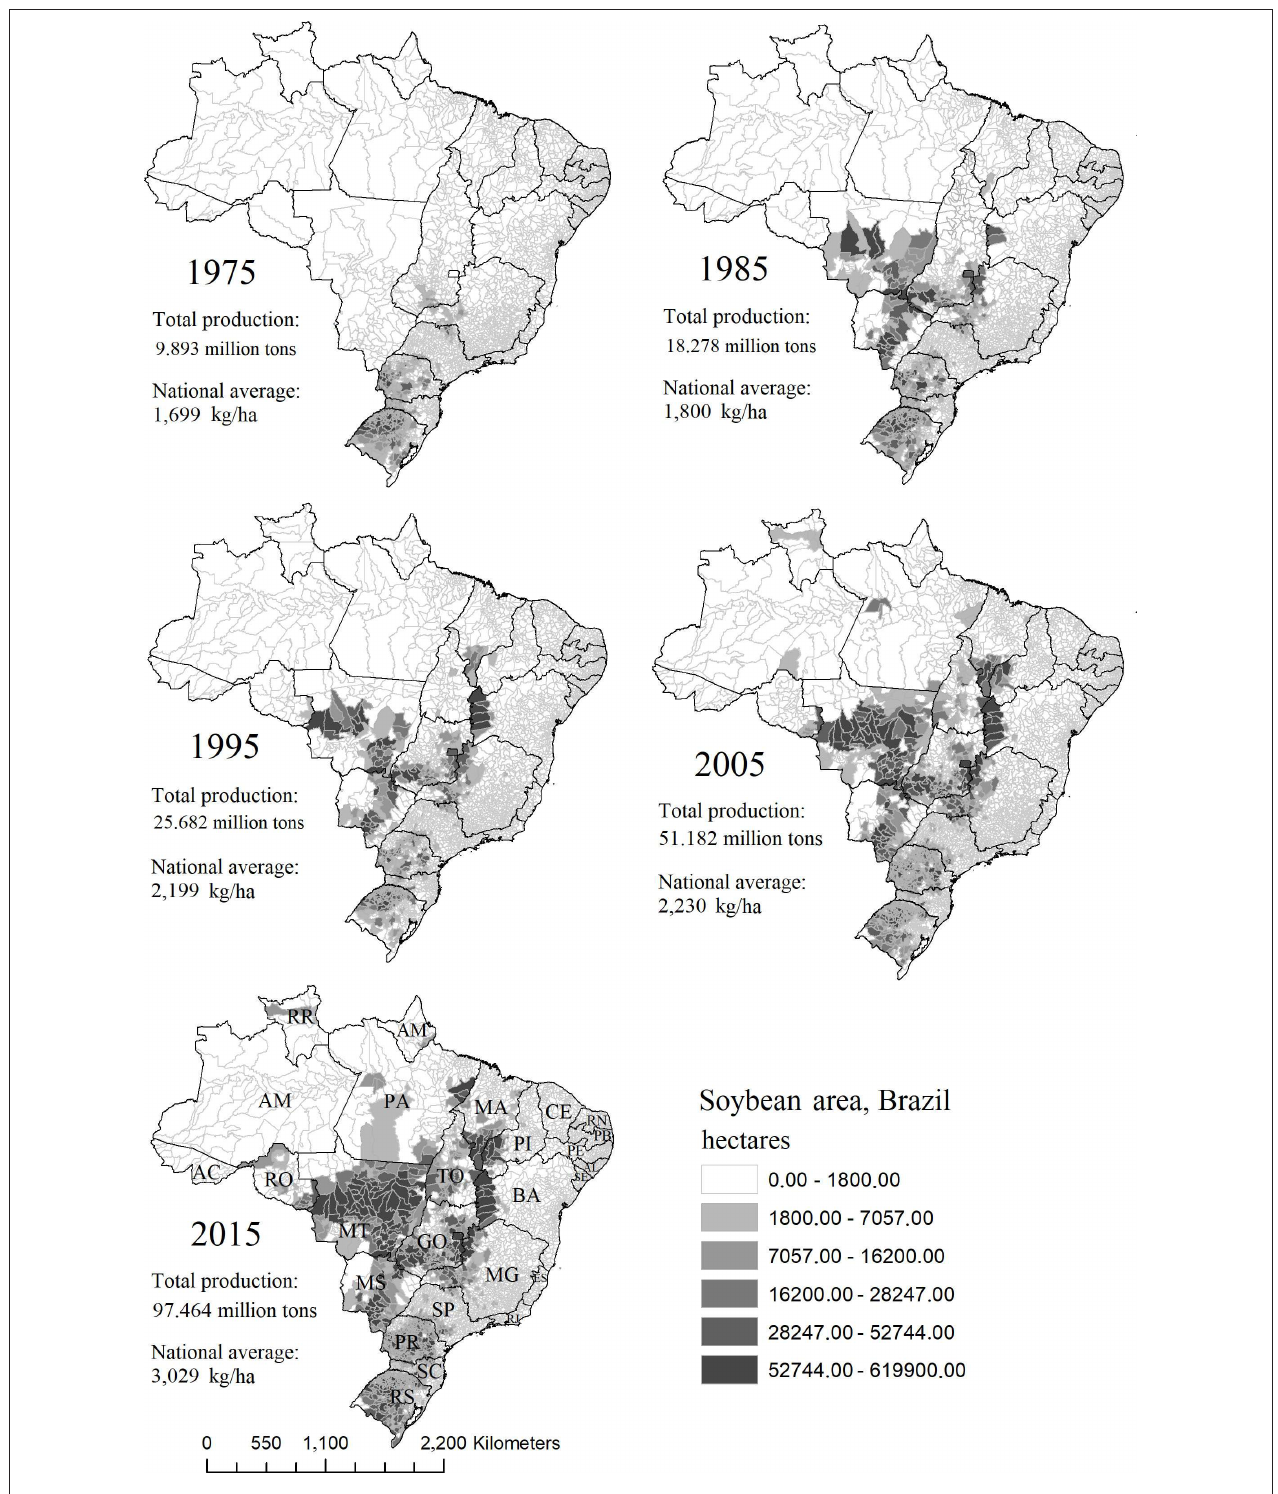
FIGURE 1 | Forty years of soybean area expansion in Brazilian municipalities, 1975–2015 (IBGE, 2017).